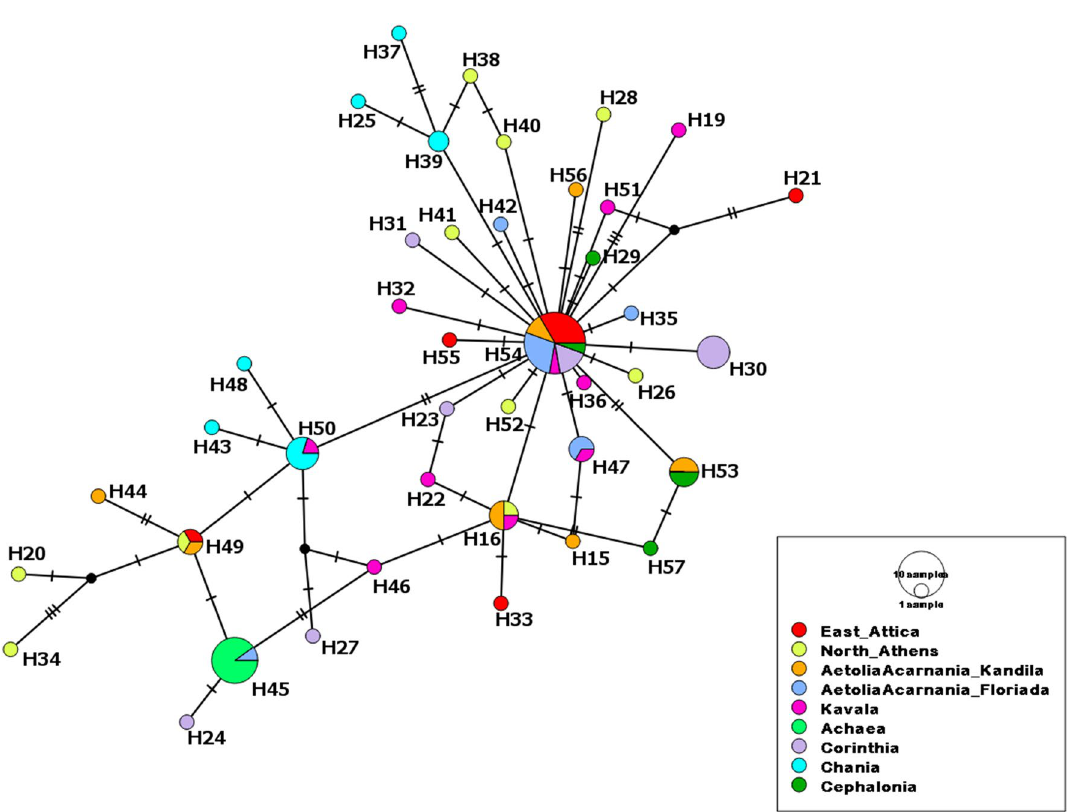
Figure 2. Haplotype cytb network of Philaenus spumarius from Greece obtained from TCS analysis with PopART v.1.7 (http://popar t.otago .ac.nz). Each colour indicates a different geographic area. Size of the circles represent the frequency of each haplotype among individuals. Hatch marks along the branches indicate the numbers of mutations and black dots represent unsampled and hypothetical haplotypes. Size of the lines are in proportion with the number of base